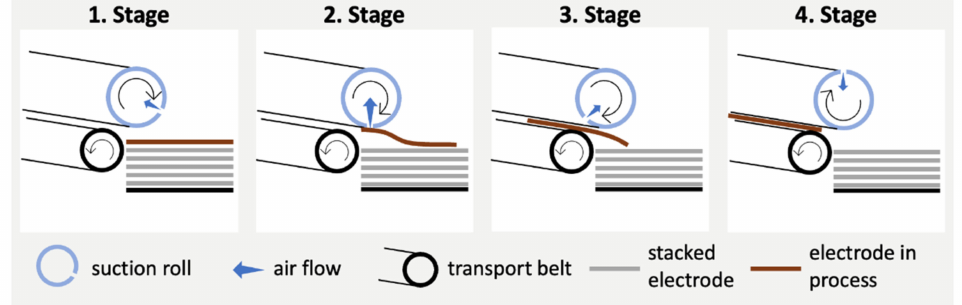
Figure 3. Separating sequence of an electrode from the separating